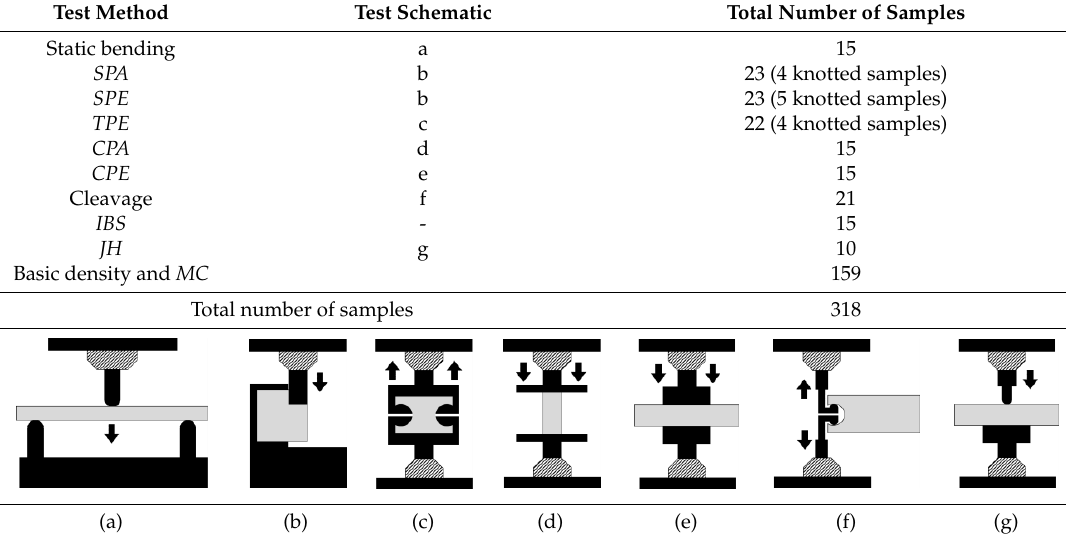
Table 2. Average MC and basic density values.